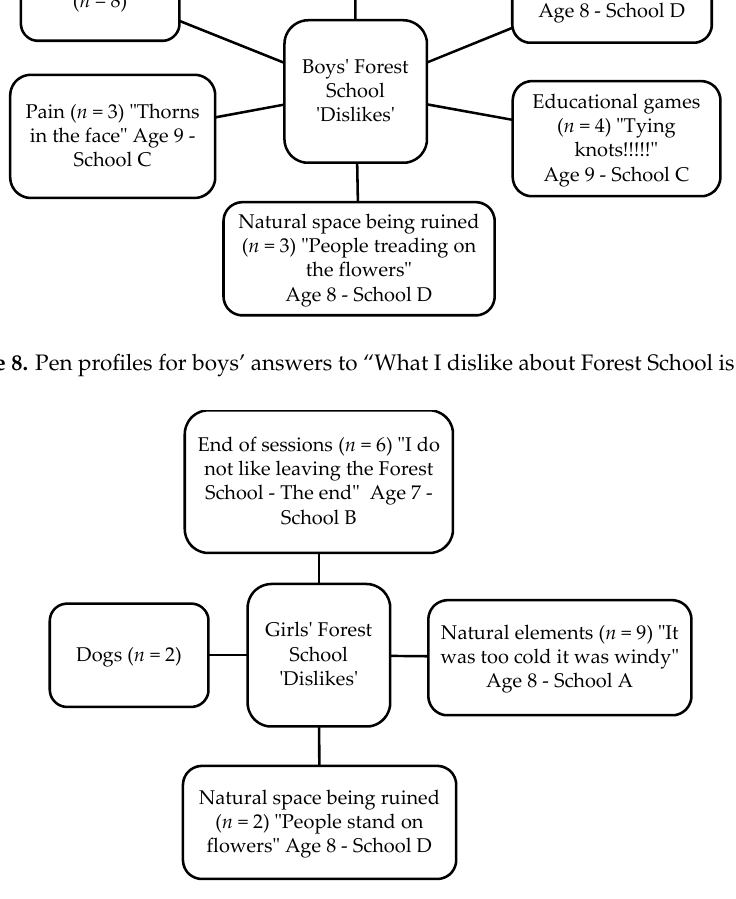
Figure 9. Pen profiles for girls’ answers to “What I dislike about Forest School is…?”.